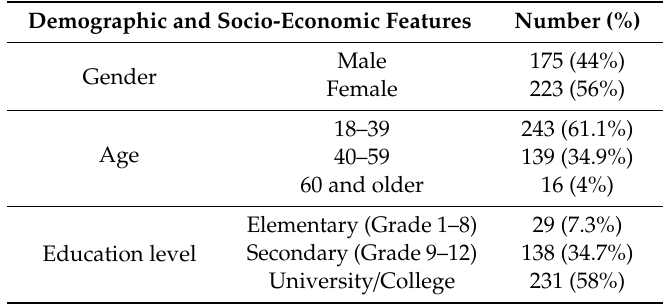
Table 2. Respondent demographic and socio-economic